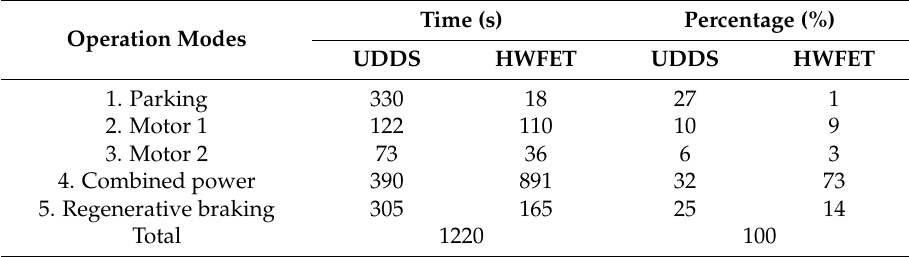
Table 3. Comparison of operation mode selection between UDDS and